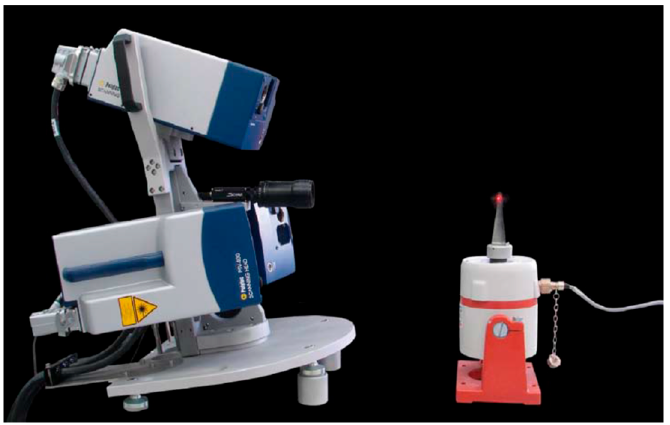
Figure 9. 3-D scanning vibrometer testing a turbine blade [121].